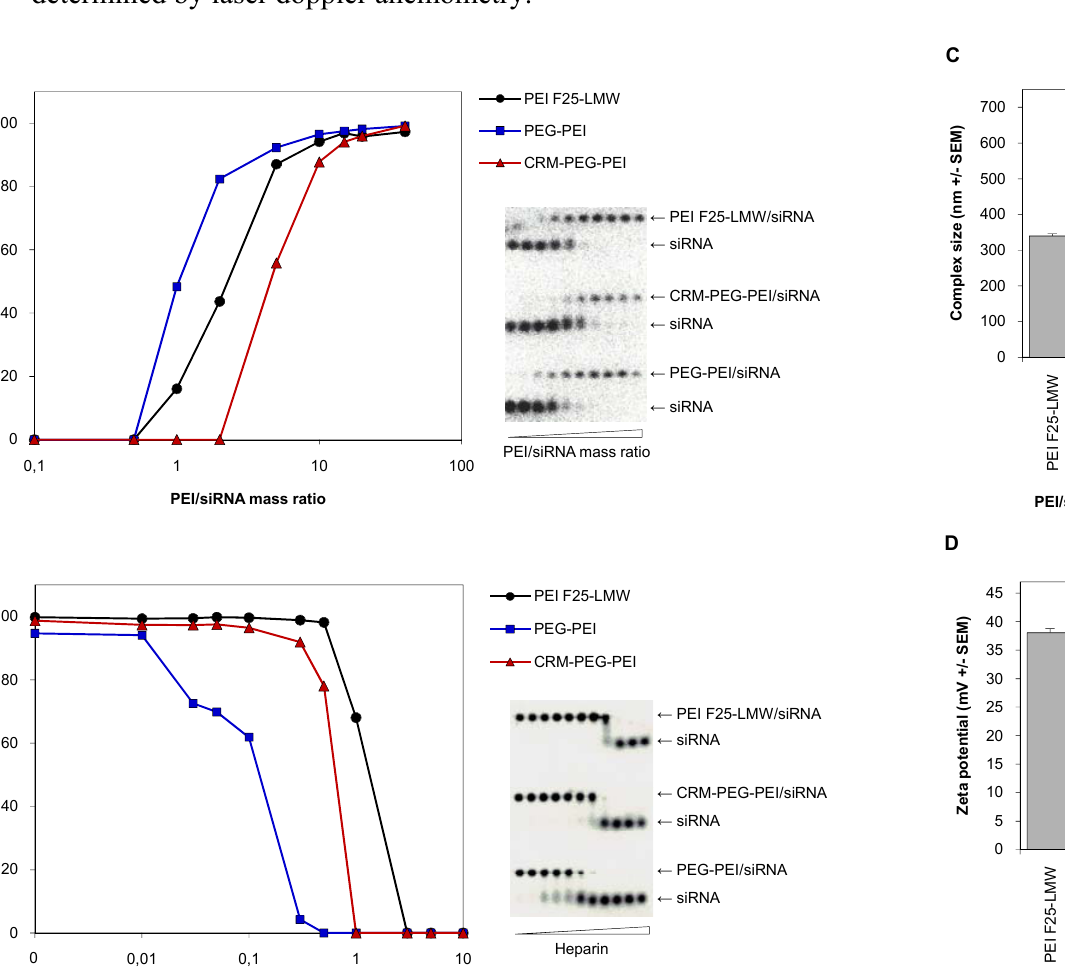
Figure 2. Characterization of PEI/siRNA complexes. ( A ) SiRNA complexation efficiencies of the parent PEI F25-LMW (black circles) and the novel PEI conjugates, PEG-PEI (blue rectangles) and CRM197-PEG-PEI (red triangles). ( B ) Stabilities of siRNA complexes against polyanions (heparin displacement assay). After incubation in the presence of various concentrations of heparin as indicated in the figure, complexes were analysed by agarose gel electrophoresis followed by autoradiography and quantitation of the 32 P-labeled free or complexed siRNA (left panels; see right panels for original gels). ( C ) Hydrodynamic diameters of PEI/siRNA complexes as determined by photon correlation spectroscopy, and ( D ) surface charges (zeta potentials) of the complexes as determined by laser doppler